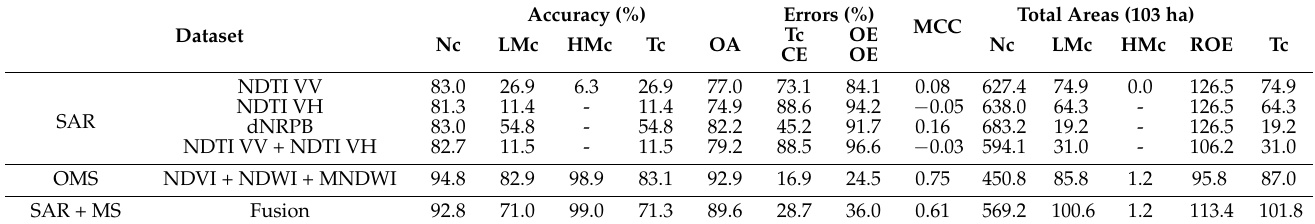
Table 12. Summary of the confusion matrix parameters and Matthews Correlation Coefficient (MCC) obtained for the North Complex fire, in comparison to the Reference Observed Event (ROE) (Nc—no changes; LMc—low-magnitude changes; HMc—high-magnitude changes; Tc—total changes;